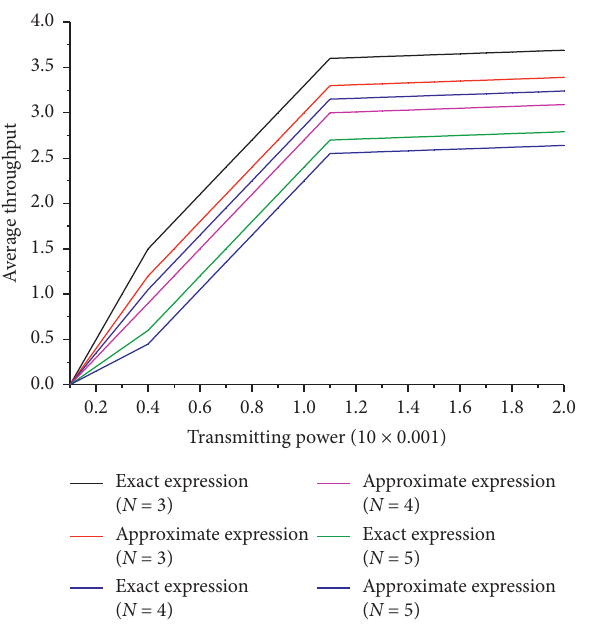
Figure 4: Schematic of single sensor throughput with P .